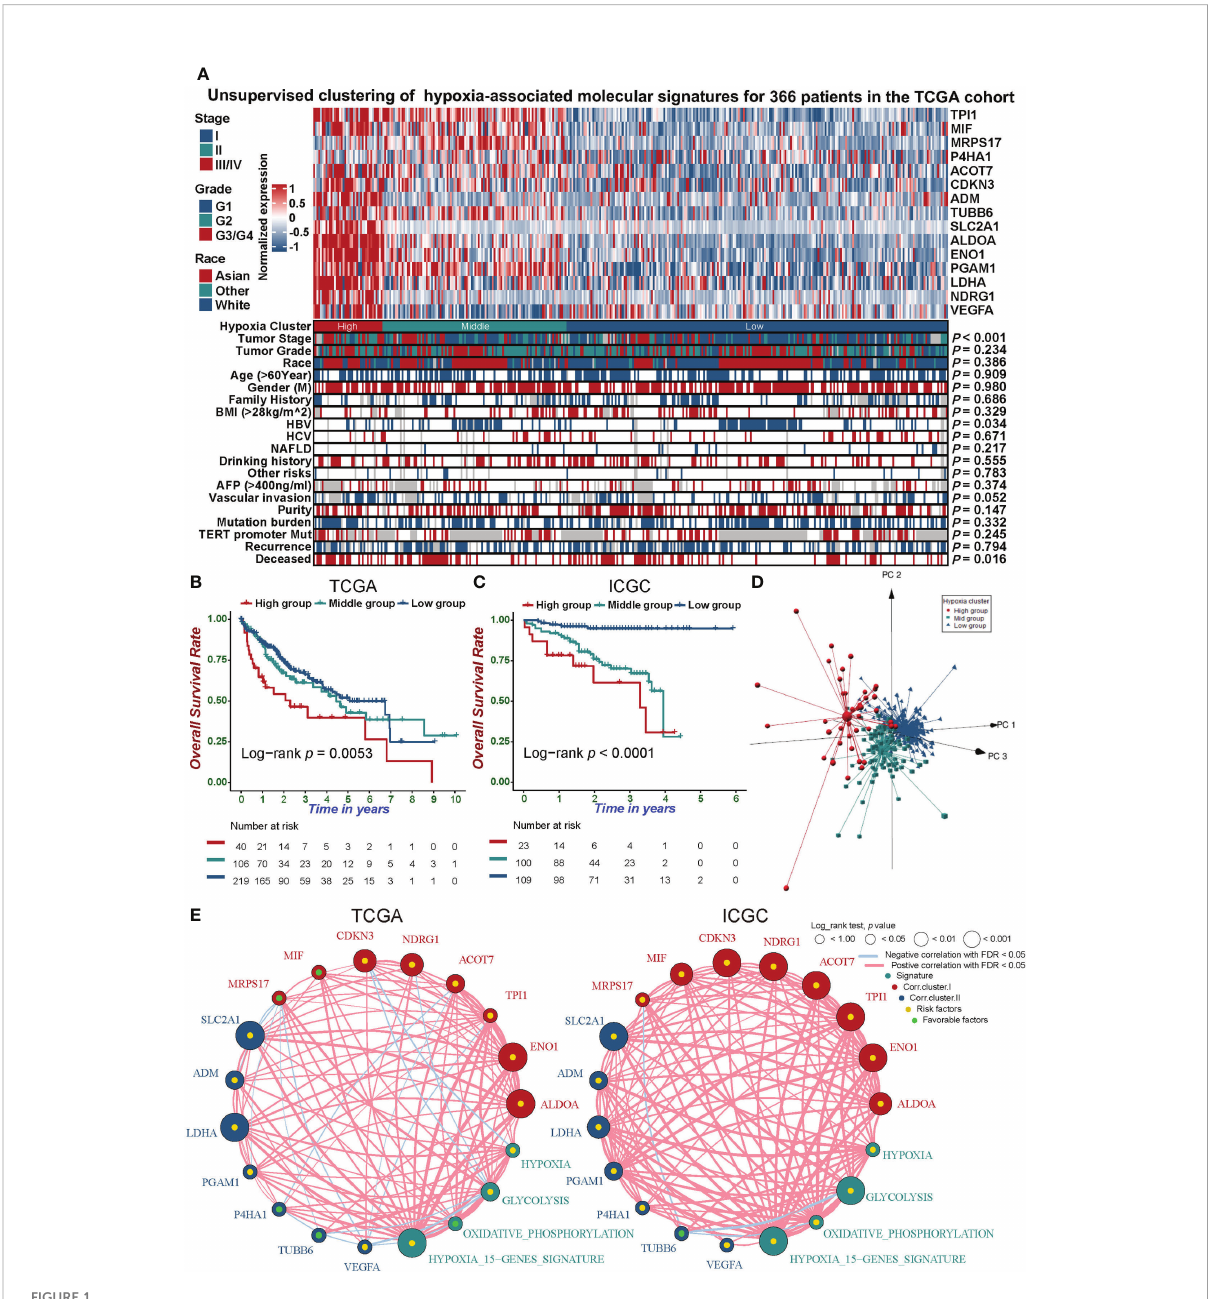
FIGURE 1 Unsupervised clustering analysis distinguishes hypoxic phenotypes of HCC. (A) Unsupervised clustering analysis of the 15-gene hypoxia signature with a comparison of clinicopathological features between three distinct clusters for TCGA-LIHC (ICGC-LIRIJP in Figure S2A). (B, C) Kaplan-Meier curves demonstrated that hypoxia phenotypes were highly associated with the overall survival of 366 patients in the TCGA-LIHC cohort (B) and 232 patients in the ICGC-LIRI-JP cohort (C) . (D) Principal component analysis for the expression pro fi les of three hypoxia clusters in the TCGA-LIHC cohort exhibiting a remarkable difference in expression between different hypoxia clusters. (E) The interplay between 15 hypoxia signature genes and hypoxia-related signatures in hepatocellular carcinoma. Green dots in the circle, favorable prognostic factors; yellow dots in the circle, risk factors. The lines linking the signature genes indicate their interplay, and thickness re fl ects the strength of correlation between the signature